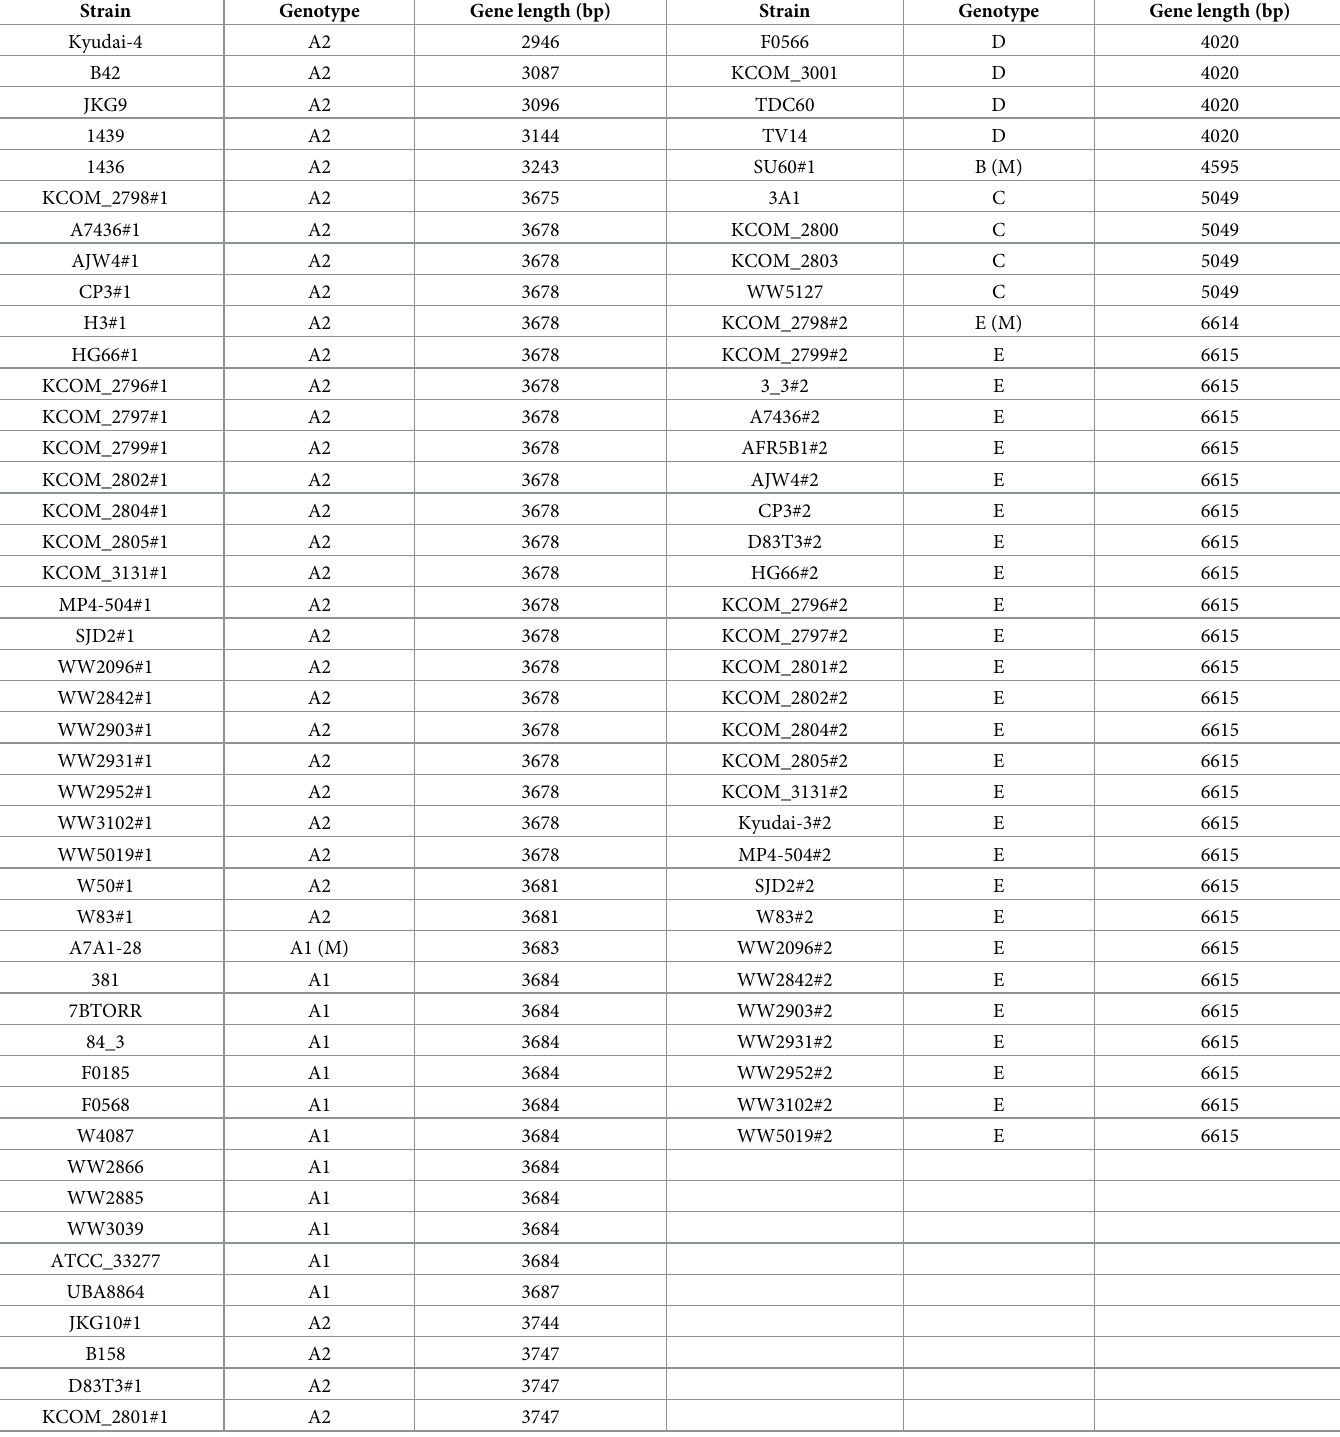
Table 4. The mfa5 genotype and gene length. Strain